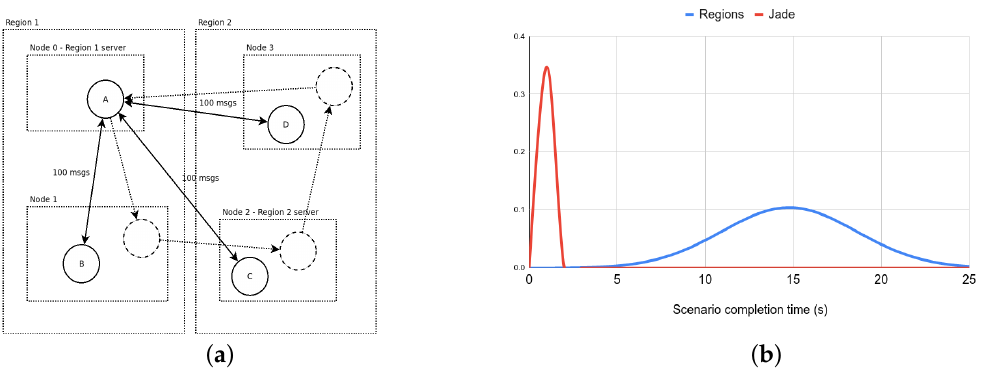
Figure 7. ( a ) The “mobility” scenario. Agent A passes 4 times by each of the 4 nodes. Agents B , C , D each exchange 100 messages with A ; ( b ) the distribution of scenario completion times (for agents B , C , D ) when using the WS-Regions Protocol and Jade, respectively. However, there are some caveats.